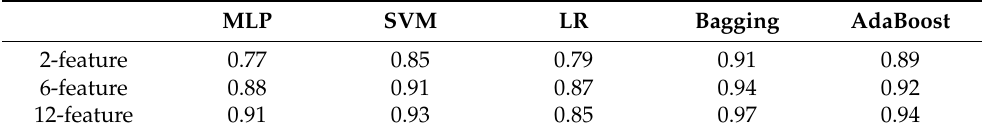
Table 1. The average accuracy of different algorithms on the identification of different defect types of aero-engine